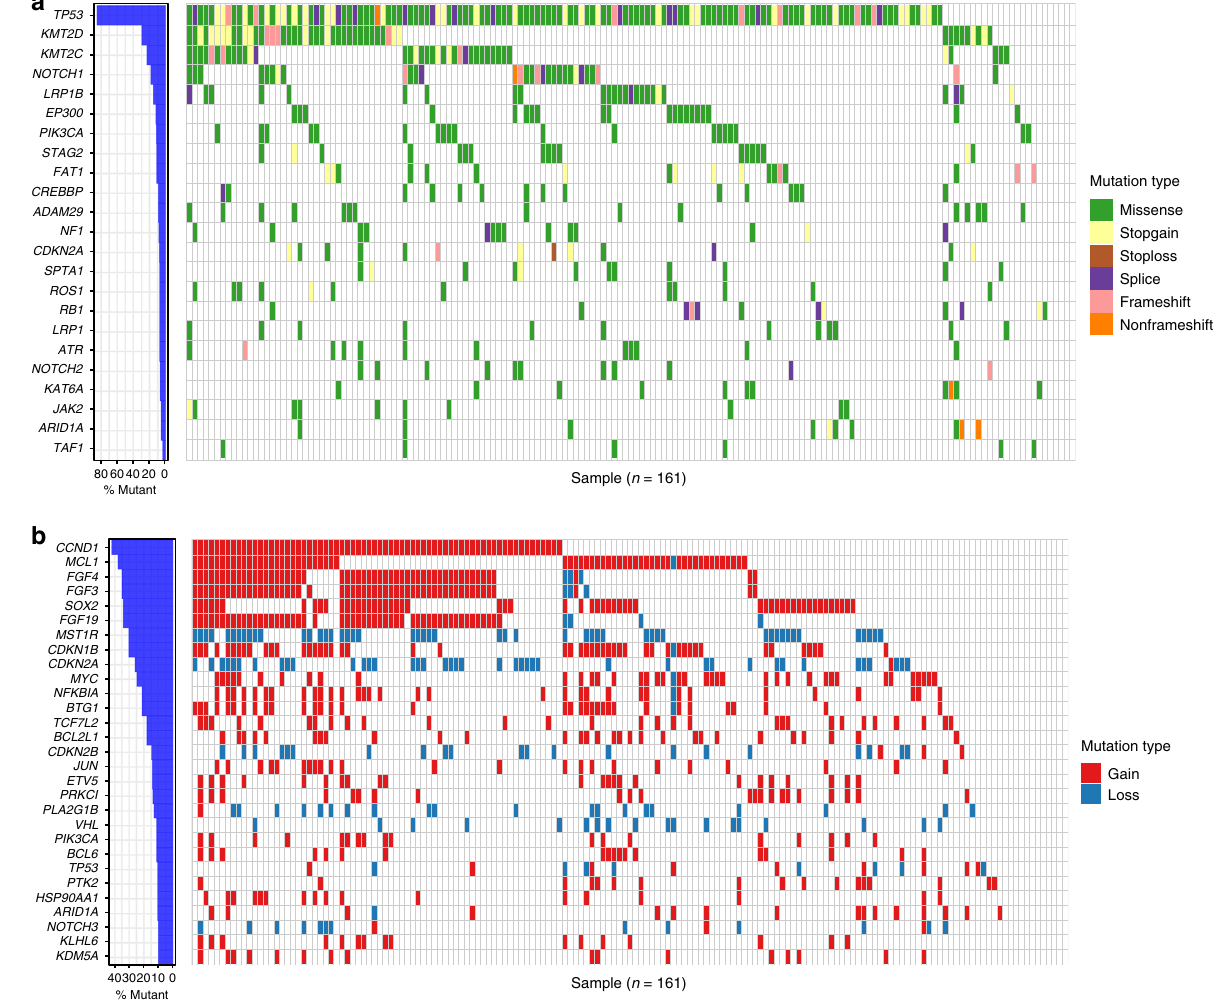
Fig. 1 Top recurrent genes harbored somatic variants and somatic CNVs. a Left panel, bar plot shows the proportion of 161 ESCC samples with somatic mutations in the speci fi c genes. Right panel, occurrence of the top 23 ranked somatically mutated genes identi fi ed by the cancer panel. Mutation subtypes (Missense, Stopgain, Stoploss, Splice, Frameshift, and Non-frameshift) are denoted by color. b Heatmap of the top recurrent genes associated with the top recurrent somatic CNVs in the 161 ESCC samples. The genes with recurrence of more than 10% are shown here. Mutation subtypes (Gain and Loss) are denoted by